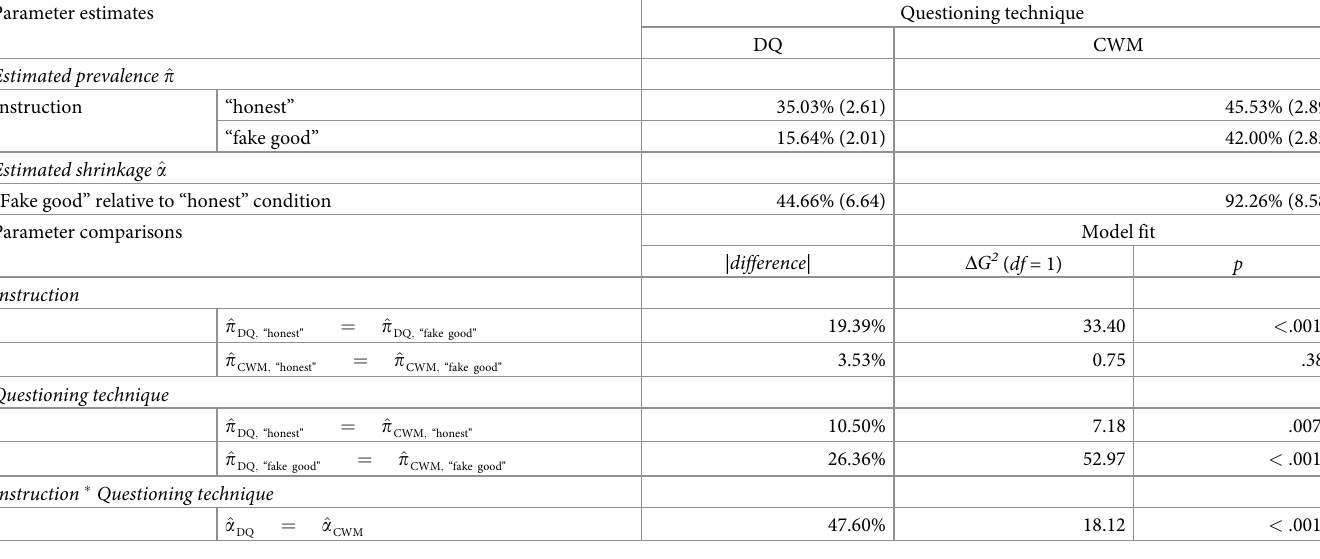
Table 2. Parameter estimates (standard errors in parentheses) and parameter comparisons for the prevalence of the sensitive attribute (“Within the past 12 months, I have crossed the street on a ‘Don’t Walk’ sign even though I was in plain sight of a child.”). Parameter